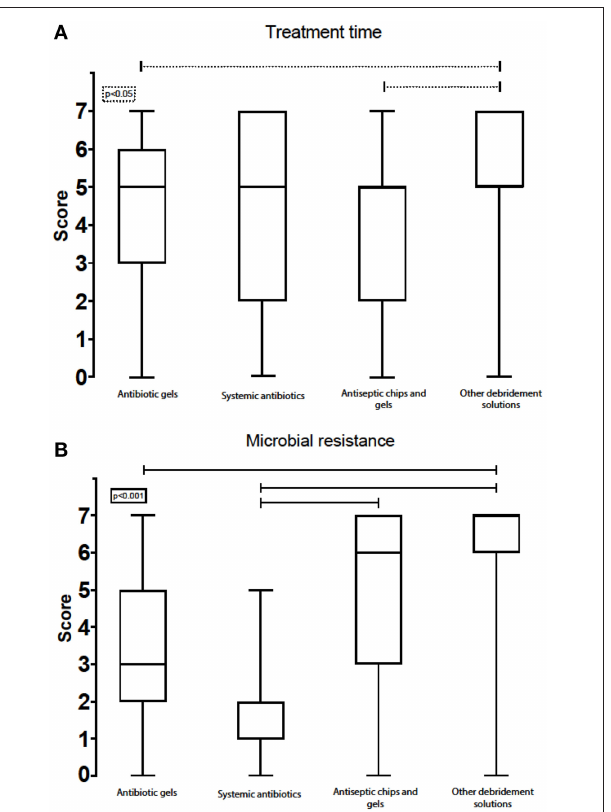
FIGURE 8 | Box-plot with score of treatment time (A) and microbial resistance (B) for the various chemical